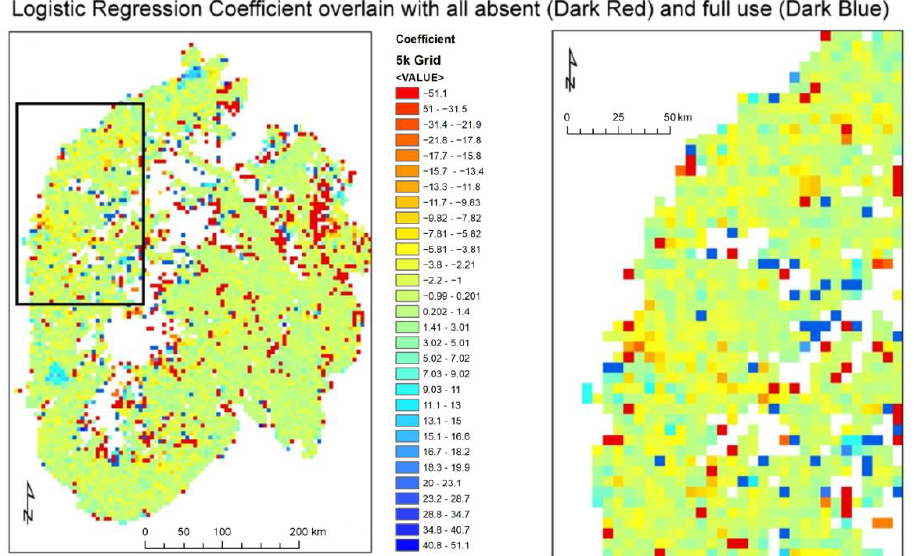
Figure 7. The long-term outlook map takes the output of the logistic regression and overlays this with a simple sum of total years in use, dark blue for “every year”, dark red for “no years”. The map on the left shows southern parts of Norway, while the figure on the right shows the map in the frame with higher resolution.